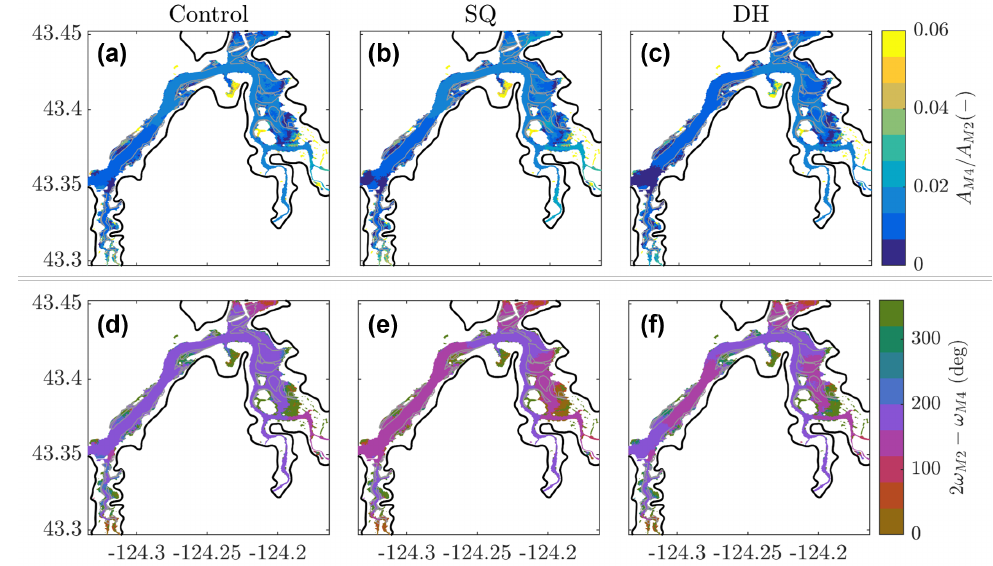
Figure 8. ( a – c ) Tidal asymmetry A M 4 / A M 2 and ( d – f ) phase difference 2 θ M 2 − θ M 4 across CBE, where values greater than 180 ◦ indicate ebb dominance and values less than 180 ◦ indicate flood dominance. Horizontal and vertical axes correspond to longitude and latitude